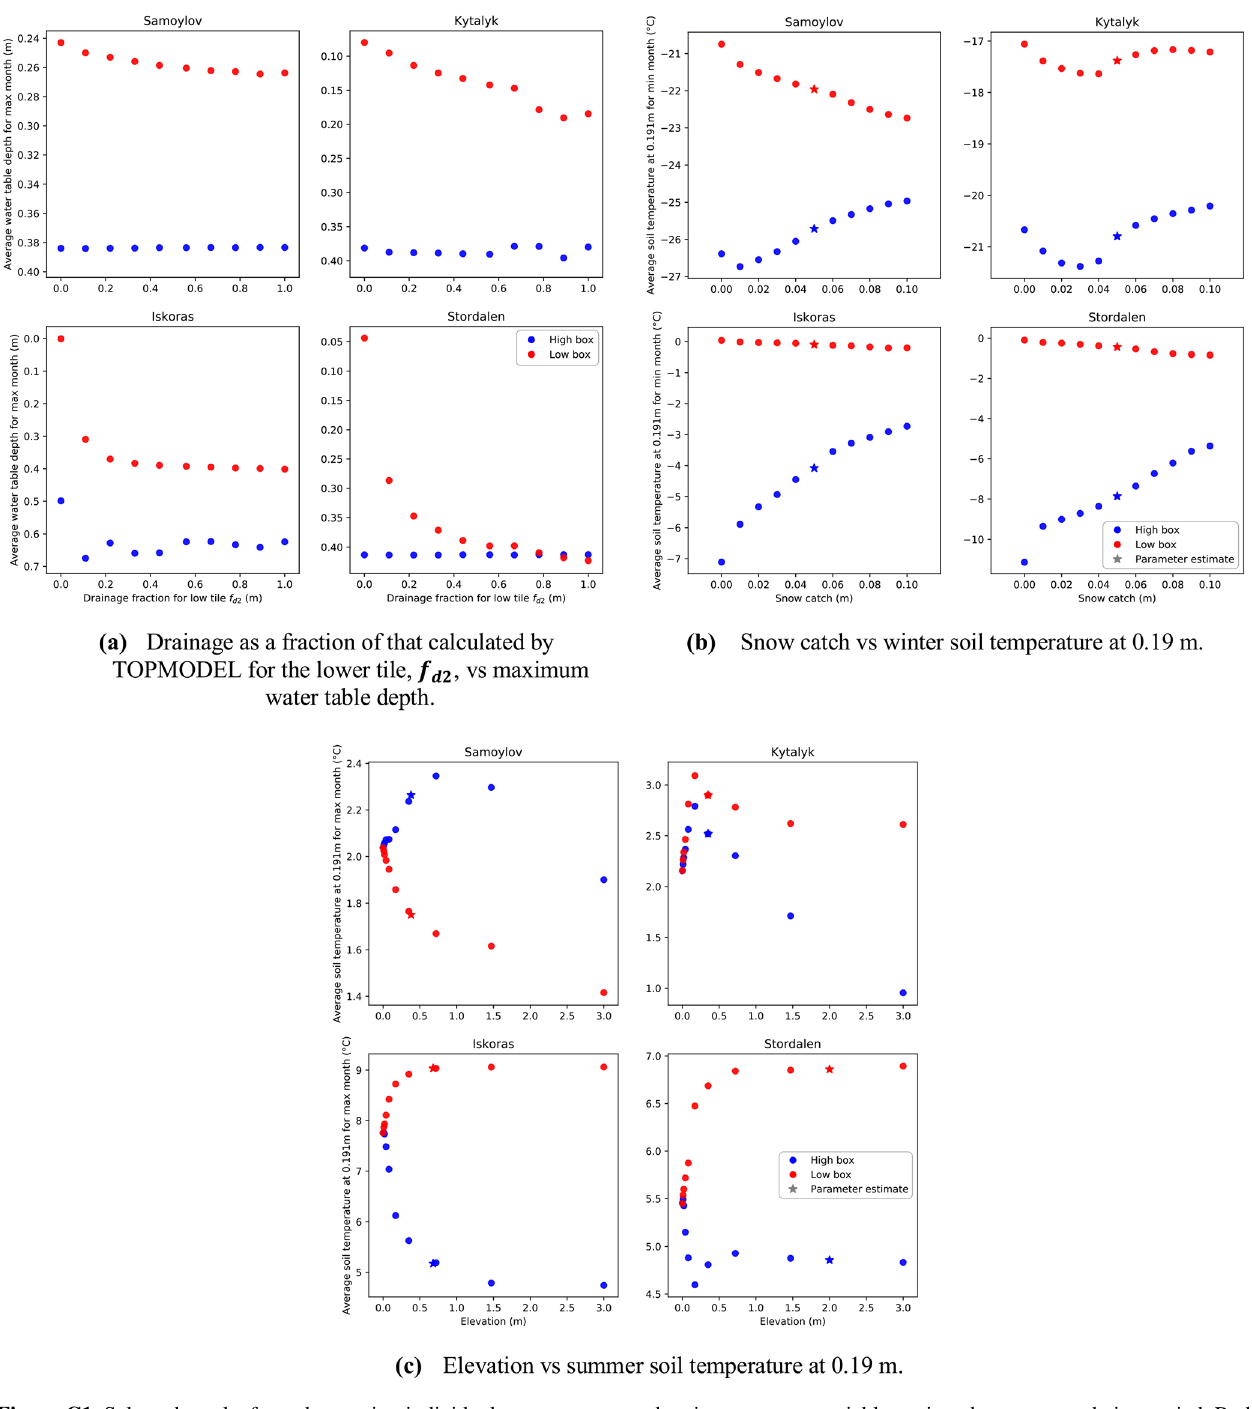
Figure C1. Selected results from the varying individual parameter runs, showing an output variable against the parameter being varied. Red and blue show the high and low tiles, respectively. Panels (b) and (c) have qbase off for both